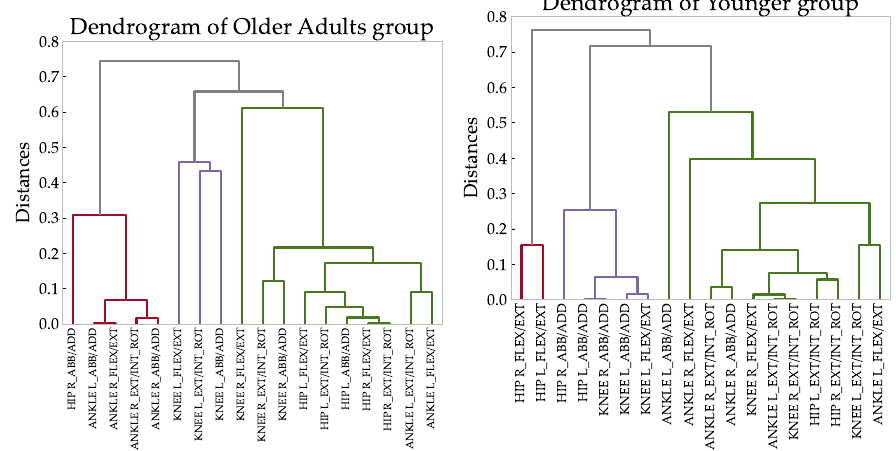
Figure 5. Dendrogram of the correlation relationship between the moment joints of the older group ( left ) and those of the younger group ( right ). The Y -axis shows the distances between the variables, where a lower node indicates a higher relationship between variables.